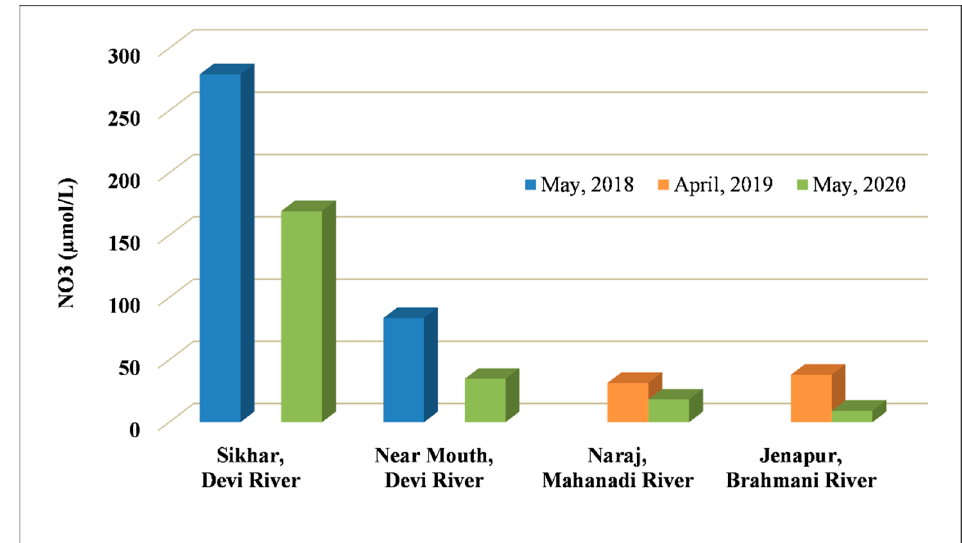
Figure 6. Pre-monsoon nitrate ( µ mol / L) data from four sampling stations from rivers near the Bay of Bengal. May 2020 NO 3 shows a sharp decline in concentration compared to previous years.